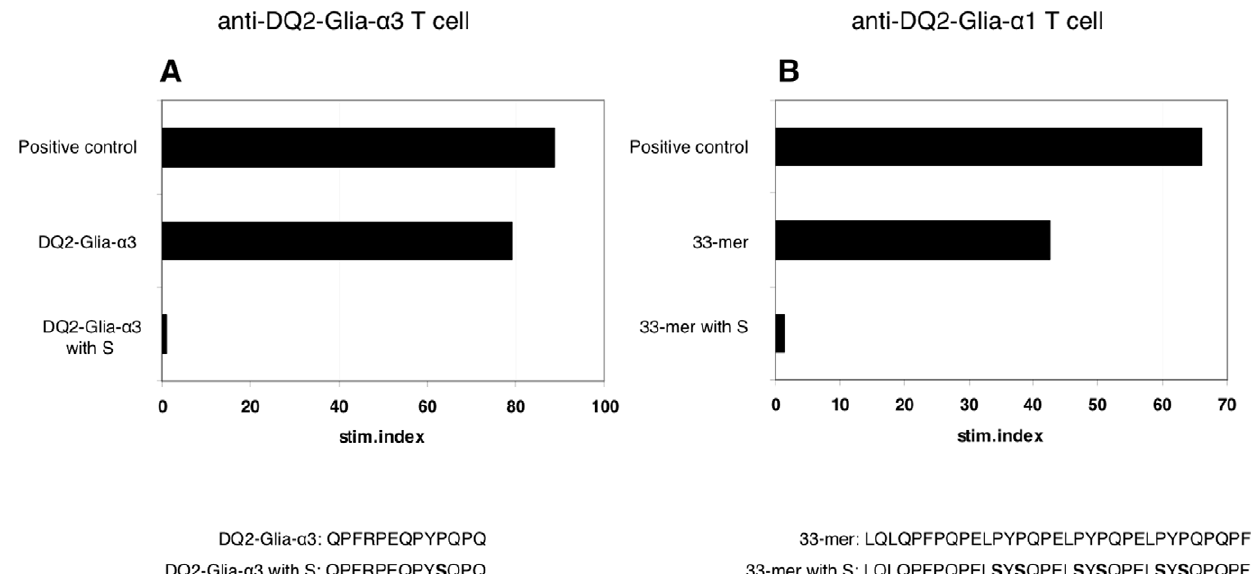
Figure 2. Amino acid substitution eliminates toxicity of known a -gliadin epitopes. The DQ2-Glia- a 3 epitope and the known 33-mer were synthesized in deamidated form either as the original sequence or after substitution in each epitope of the prolines at position 8 with serine. These peptides were tested in T cell proliferation assays. A: T cell proliferation assay using a DQ2-Glia- a 3 T cell clone. B: T cell proliferation assay using a DQ2-Glia- a 1 T cell clone. Positive control: synthetic peptide encoding the specific minimal T cell epitope. Stim. index: stimulation index defined as the specific proliferation of a sample divided by the background proliferation.